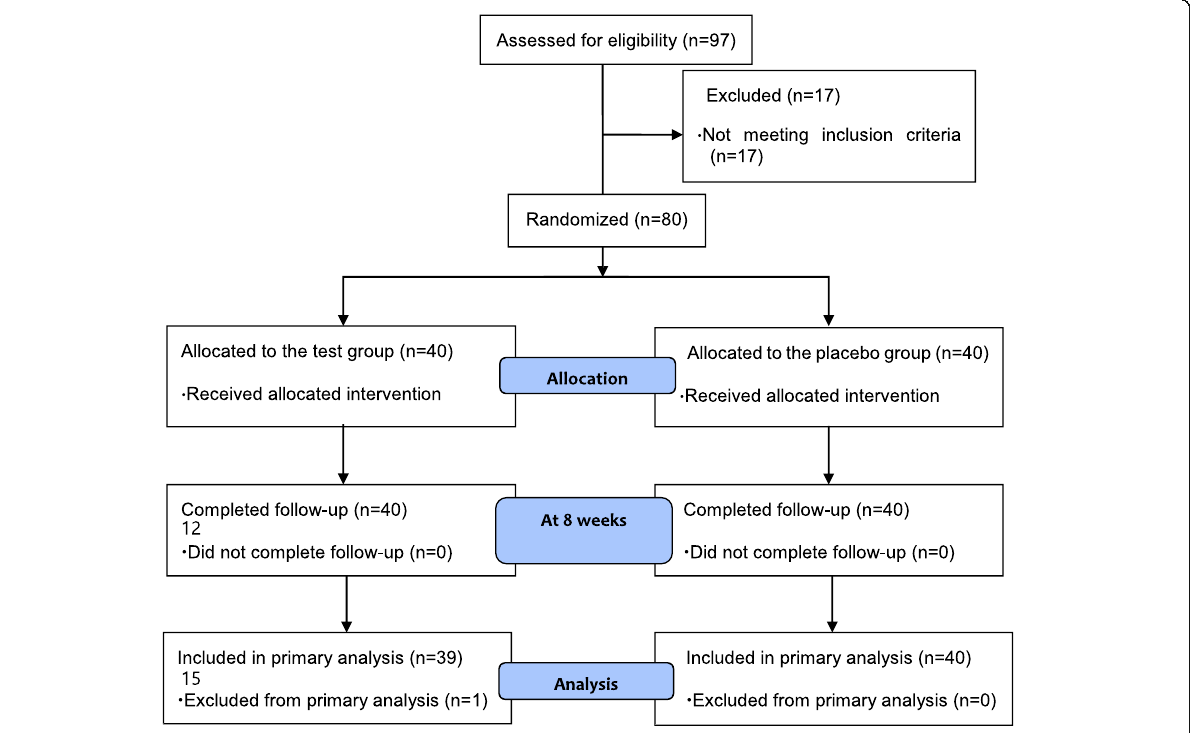
Fig. 1 Study flow diagram based on the CONSORT 2010 flow